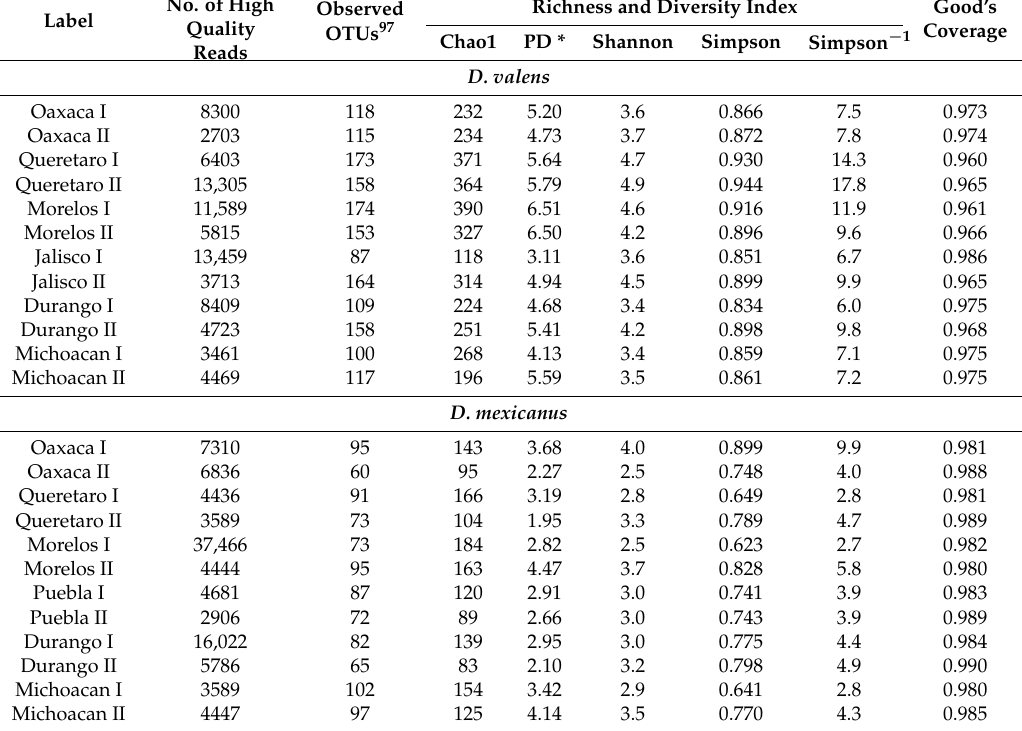
Figure 1. Locations studied of the Dendroctonus valens (green) and D. mexicanus (orange). Grey dot = sampled localities; dot line = collected species. Table 1. Summary of pyrosequencing data and alpha diversity of Dendroctonus valens and D. mexicanus.